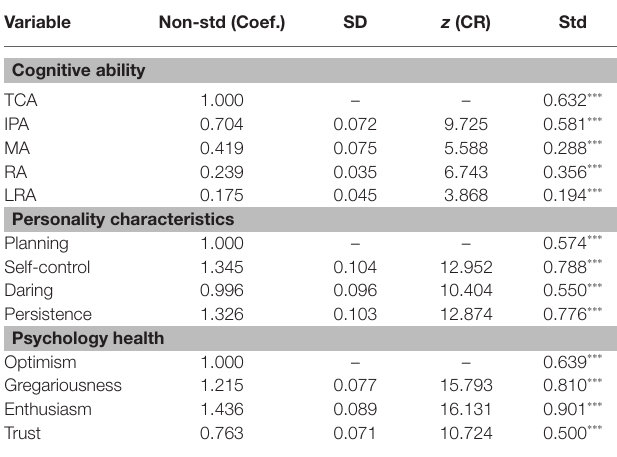
TABLE 3 | Factor loading coefficient table. Variable Non-std